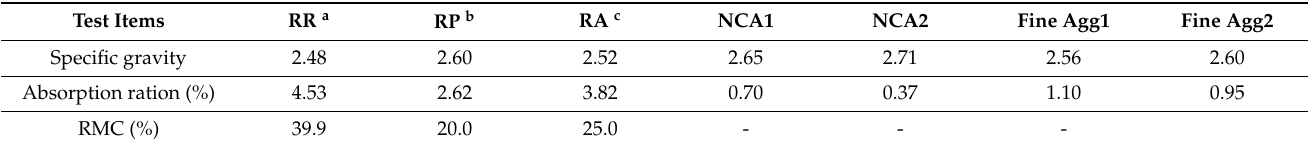
Table 1. Basic RCA